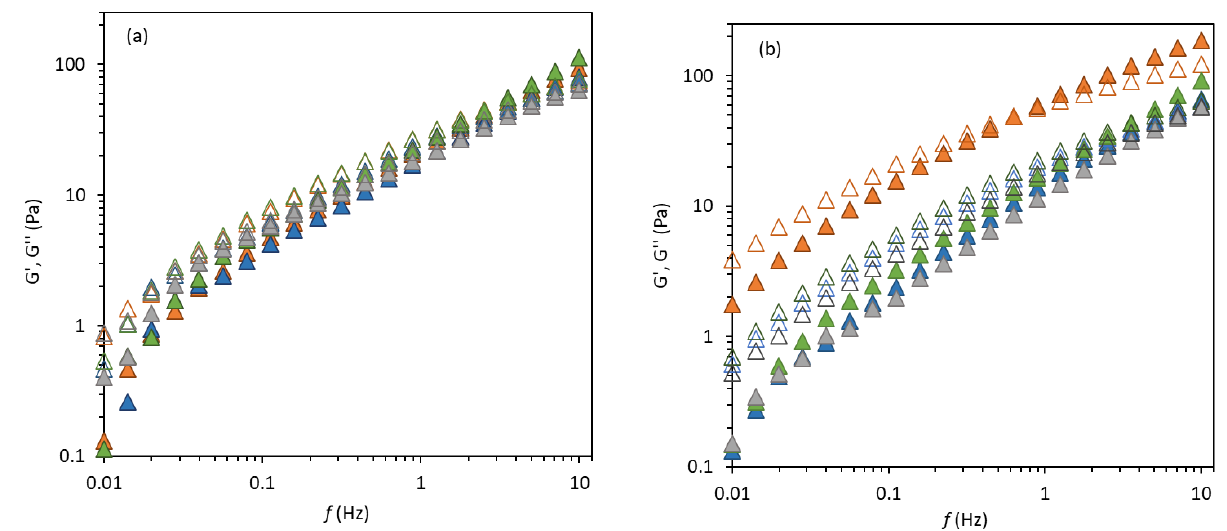
Figure 7. Mechanical spectrum for formulations C1 ( a ) and C2 ( b ) during the storage time: t = 1 (orange), t = 3 (blue), t = 7 (green), and t = 45 (grey). G ′ (closed triangle) and G ″ (open triangle).